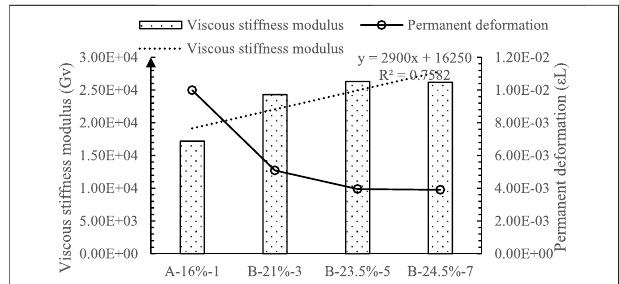
FIGURE 3 | RCR test results of modi fi ed asphalt with different rotational